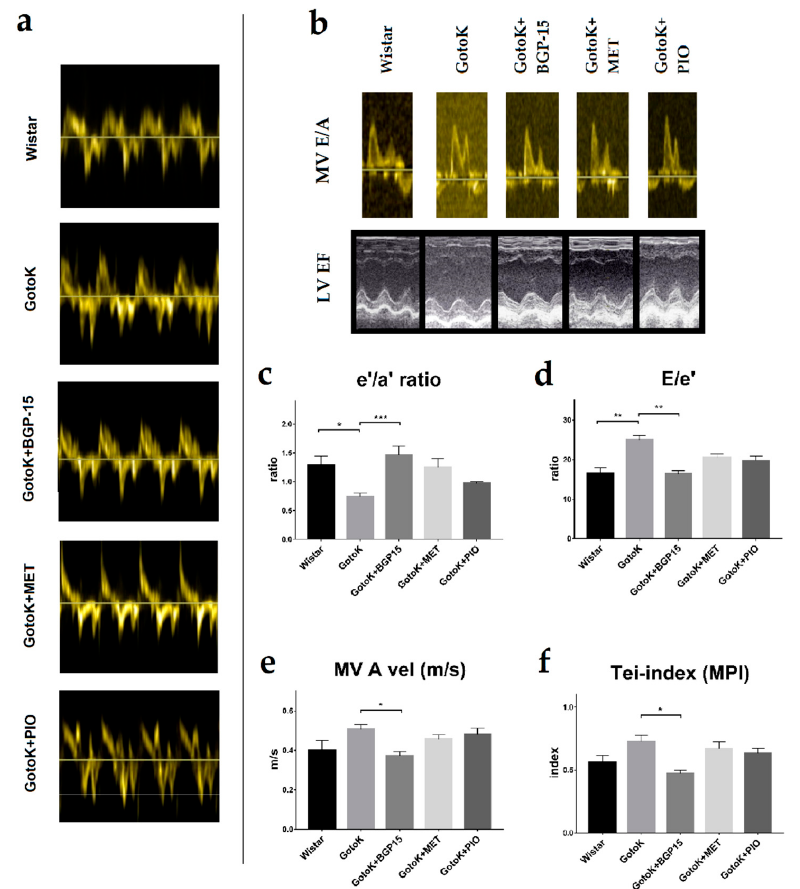
Figure 3. Echocardiographic parameters of rat groups. Data and representative images obtained from healthy control (Wistar) and diabetic GotoK rats treated with vehicle (GotoK), 10 mg/kg BGP-15 (GotoK + BGP15), 100 mg/kg metformin (GotoK + MET) and 10 mg/kg pioglitazone (GotoK + PIO). ( a ) representative images of septal annular tissue velocities (s ′ , e ′ and a ′ waves) of rats, recorded by TDI echocardiography; ( b ) representative images of mitral inflow velocities (E and A waves), obtained by Doppler imaging, and representative parasternal long axis views of the left ventricle, obtained by M-mode (EF: ejection fraction); ( c ) graph of septal e ′ /a ′ ratio of treatment groups; ( d ) calculated E/e ′ ratios of rats; ( e ) graph of mitral valve (MV) atrial (A)-wave velocities; ( f ) myocardial performance, shown as Tei-index of treatment groups. All data is presented as mean SEM, n = 6/group, Kruskal-Wallis test with Dunn’s post-test. Asterisks denote the level of significance (* p < 0.05; ** p < 0.01).